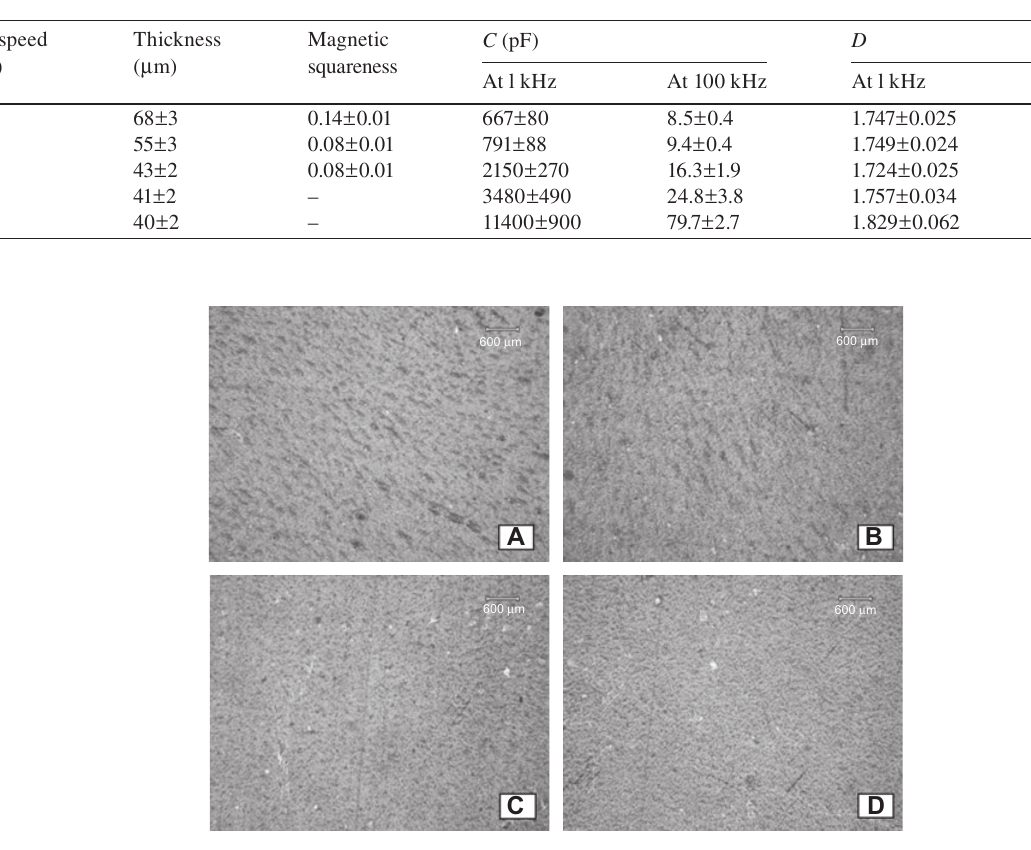
Table 1 Thickness, magnetic squareness and dielectric properties of PVDF/Ni on PCB substrates obtained by using varying spin coating speeds.